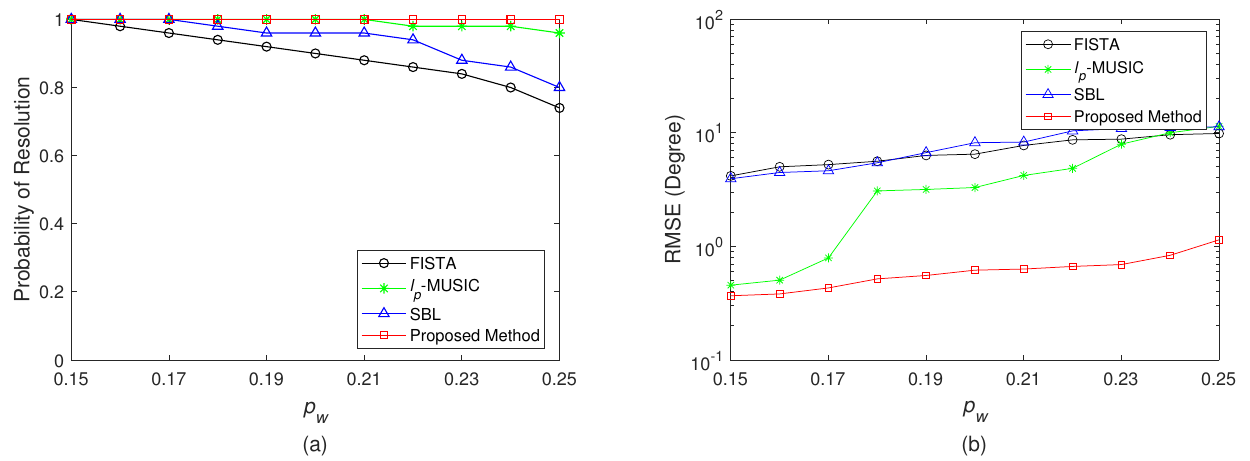
Figure 3. Performance comparison of the algorithms as a function of p w . ( a ) Probability of resolution. ( b ) RMSE.